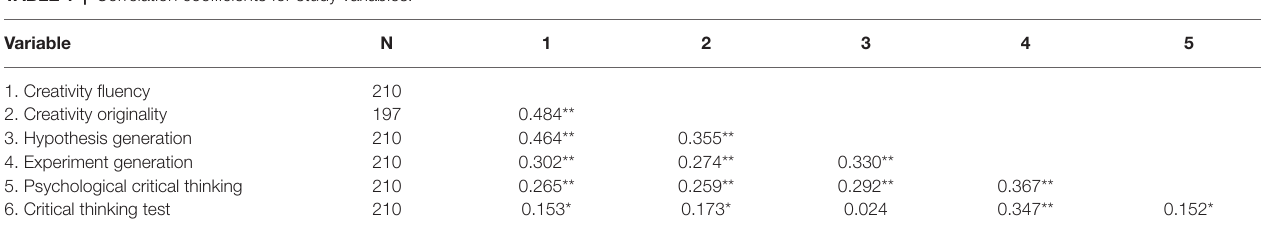
TABLE 1 | Correlation coefficients for study variables.